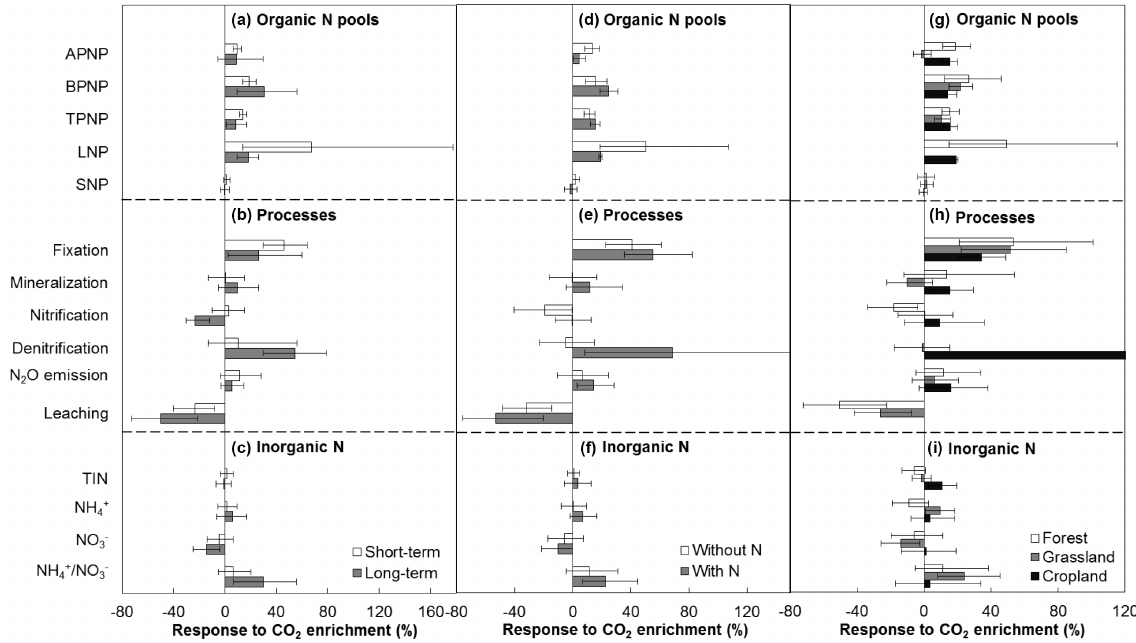
Figure 3. Responses of terrestrial nitrogen pools and processes to CO 2 enrichment (Mean ± 95% confidence interval) as regulated by experimental durations ( a–c ; short-term: ≤ 3 years vs. long-term: >3 years), nitrogen addition (d–f) , and ecosystem types (g–i) . Please see Fig. 1 for